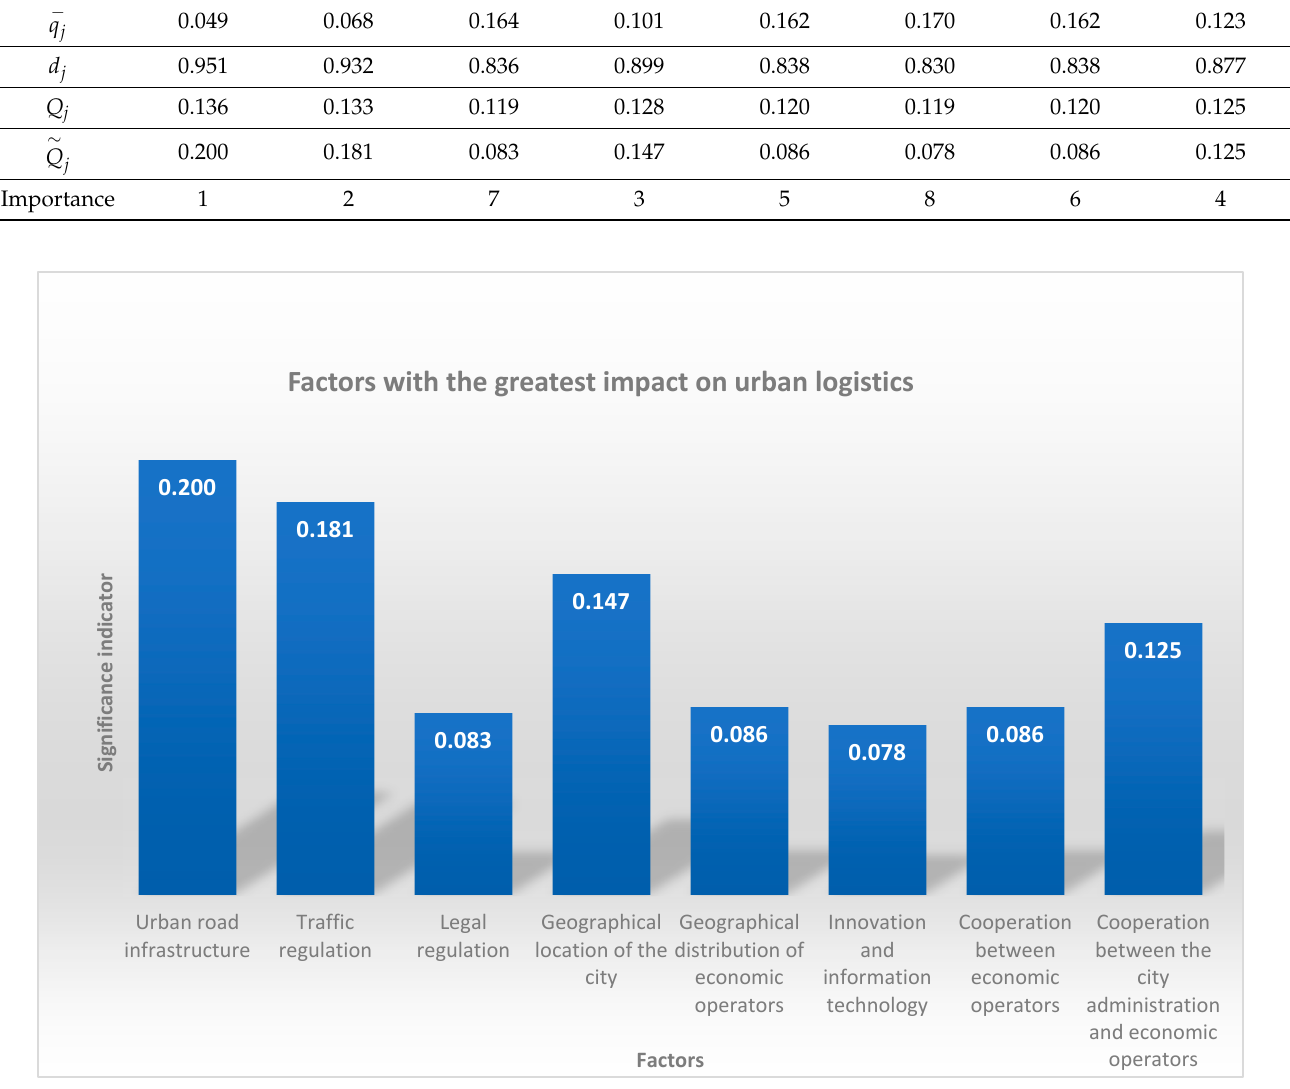
Figure 1. Factors that have the greatest impact on a city’s logistics system .